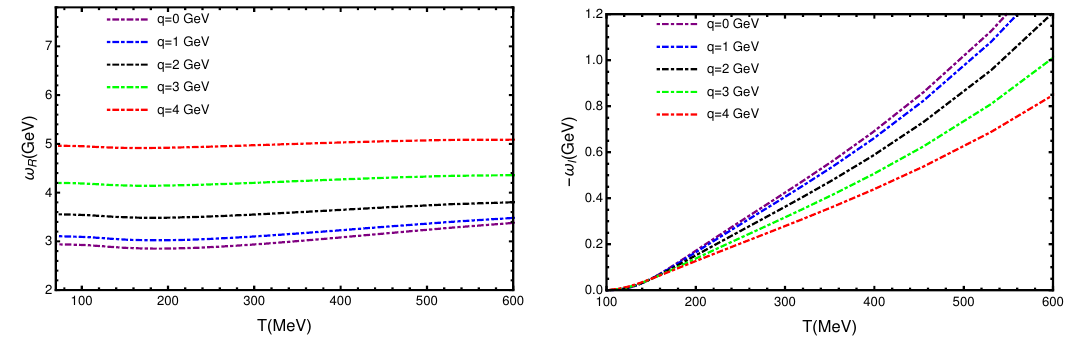
Figure 7 . Numerical results for the quasinormal modes of the charmonium in the longitudinal direction as function of the temperature.